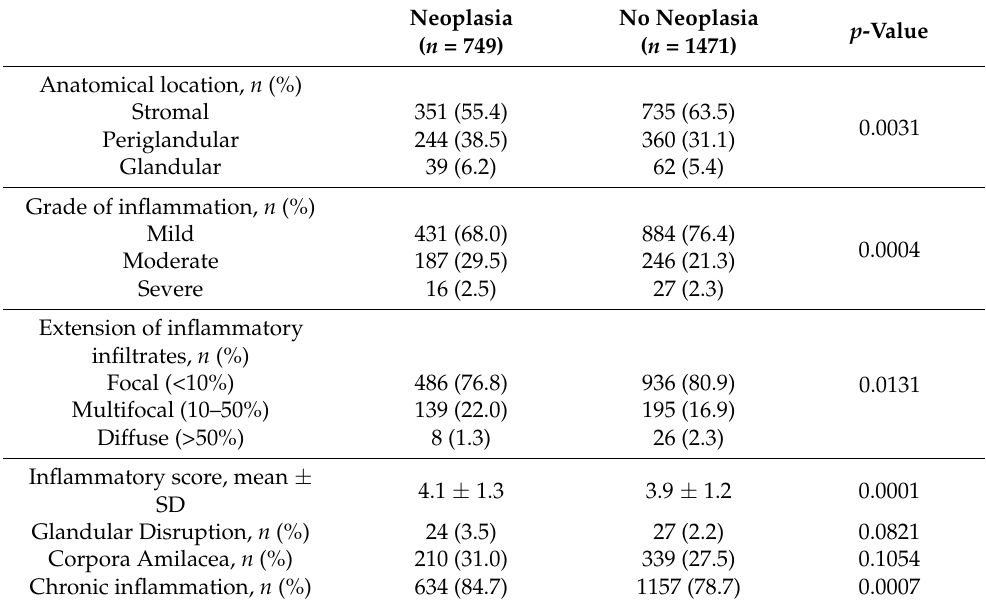
Table 3. The relationship between inflammation and neoplasm.